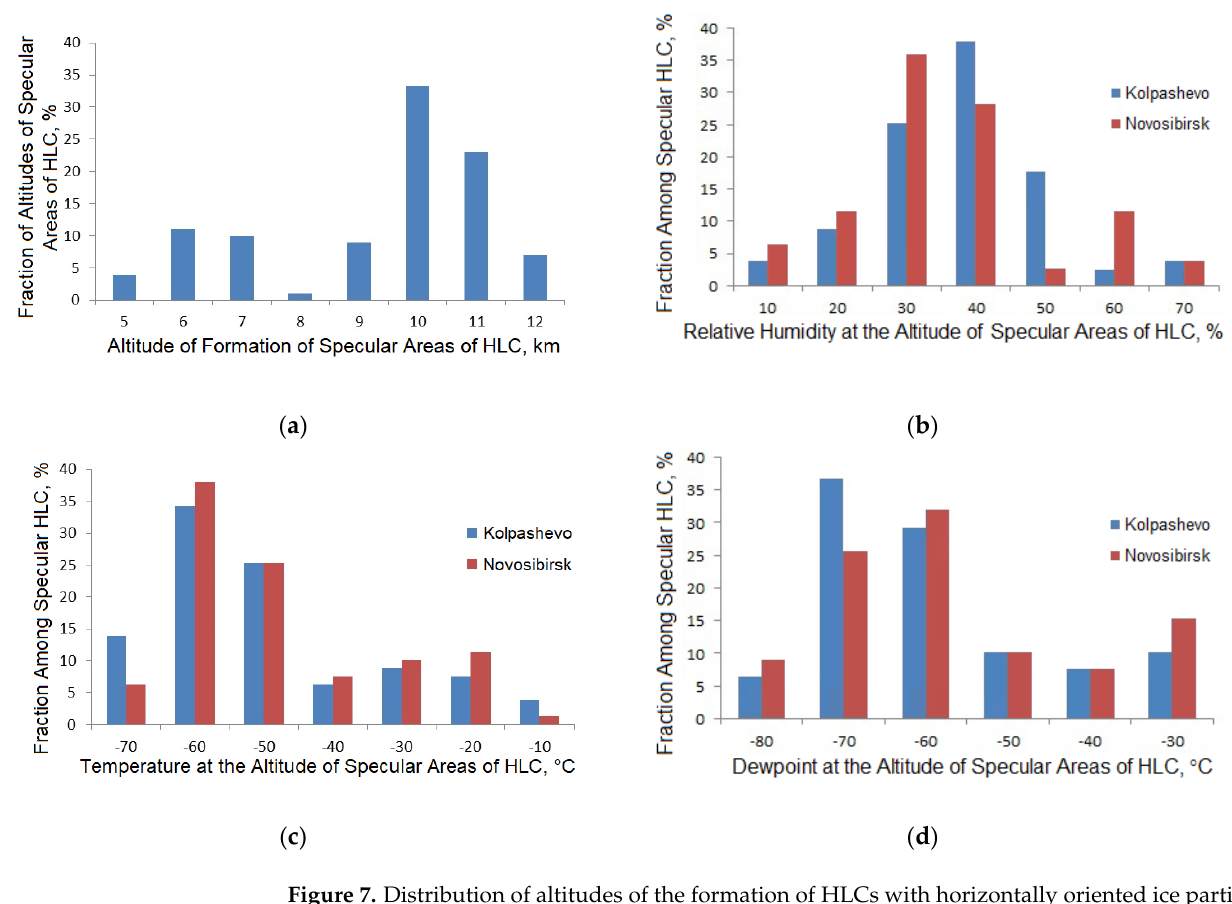
Figure 6. Distribution of HLC specular area sizes (2016–2020).